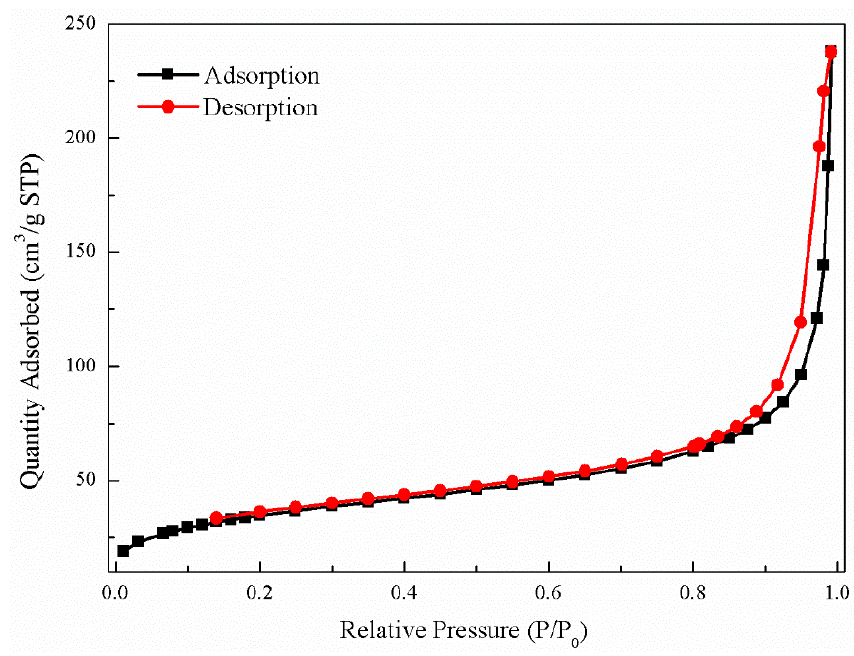
Figure 5. BET isotherm of n